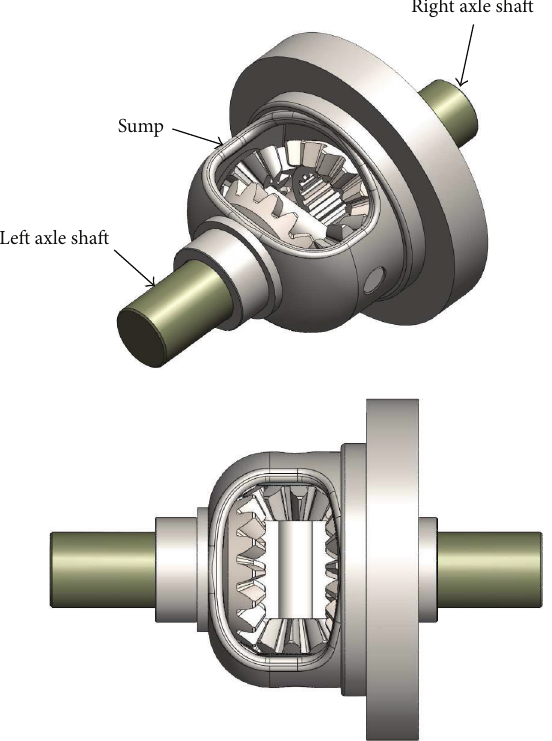
Figure 1: Differential gearbox (with its sump and the axle